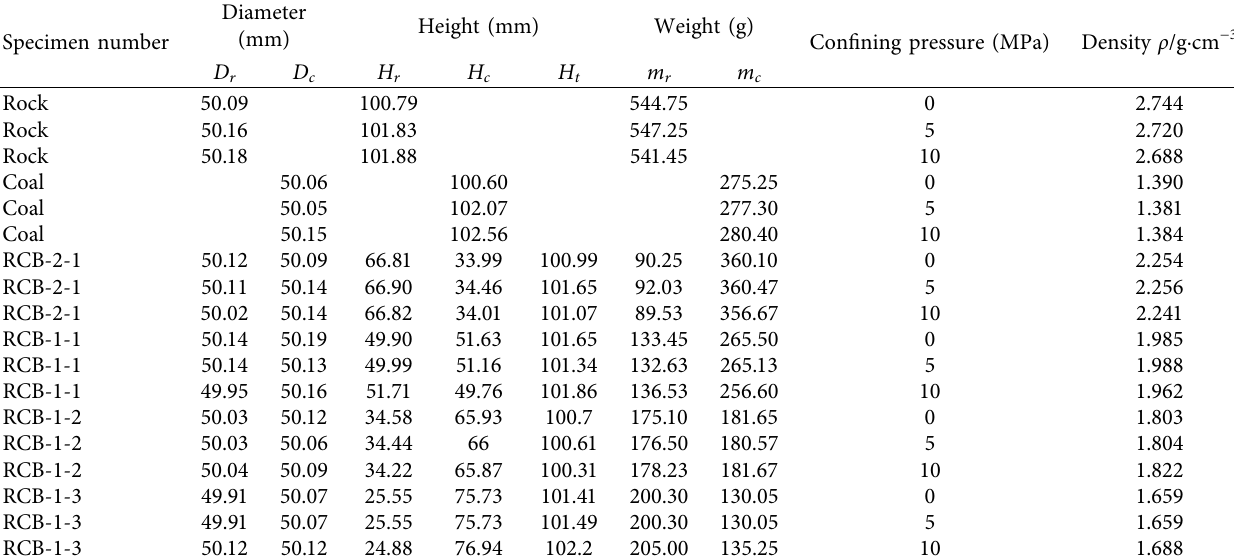
Table 1: Grouping of coal-rock combined samples and their basic